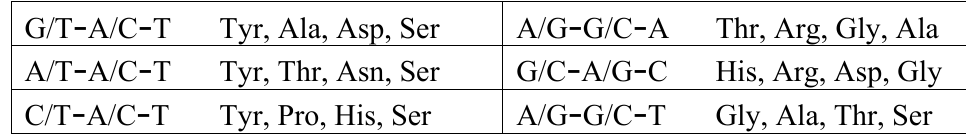
Table 3. Selected codon sets from Feelouse et al . [46], which limit randomization to four possible amino acids.